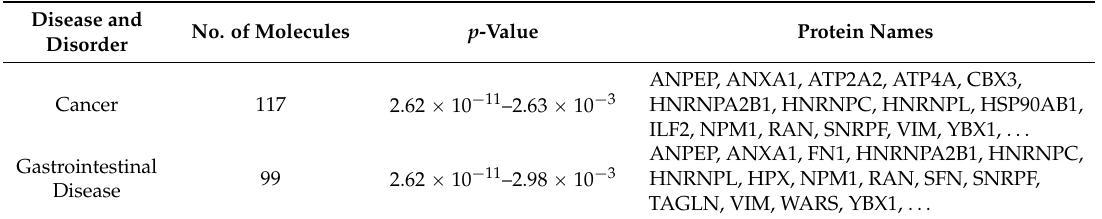
Table 1. Dysregulated proteins and related disorders analyzed by IPA.